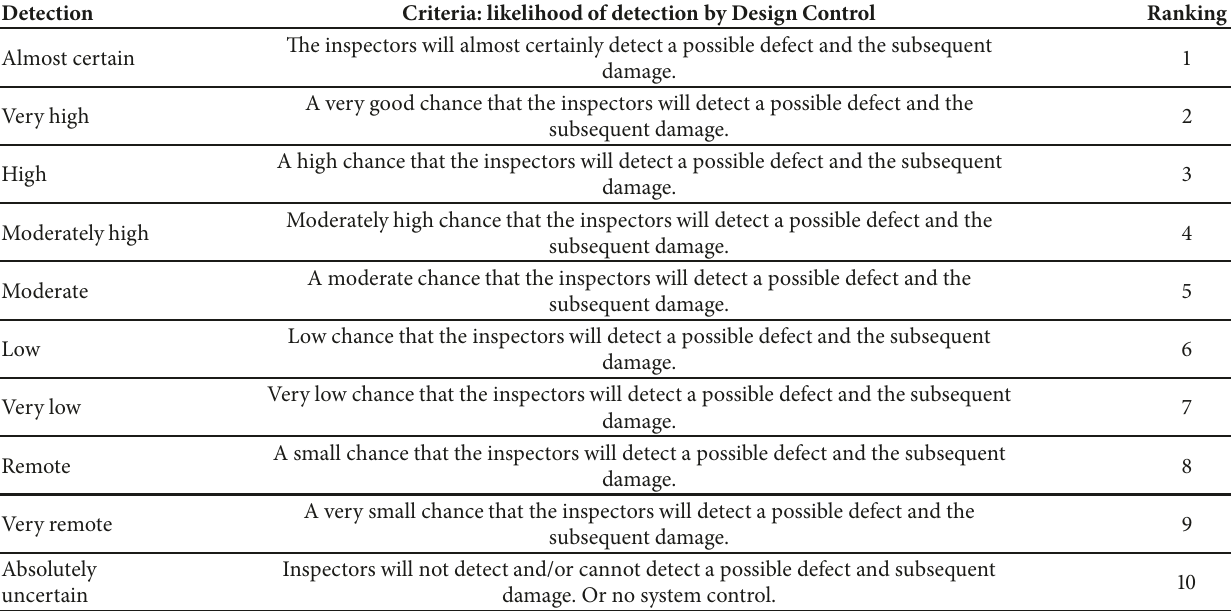
Table 5: Failure mod detection evaluation